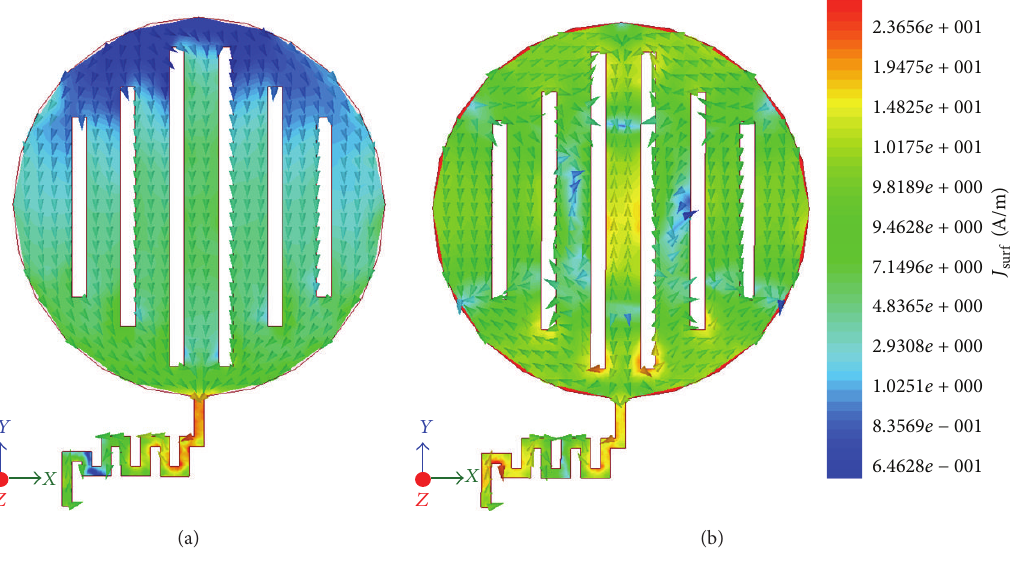
Figure 6: Distribution of surface current at 0.9 GHz and 2.5 GHz.